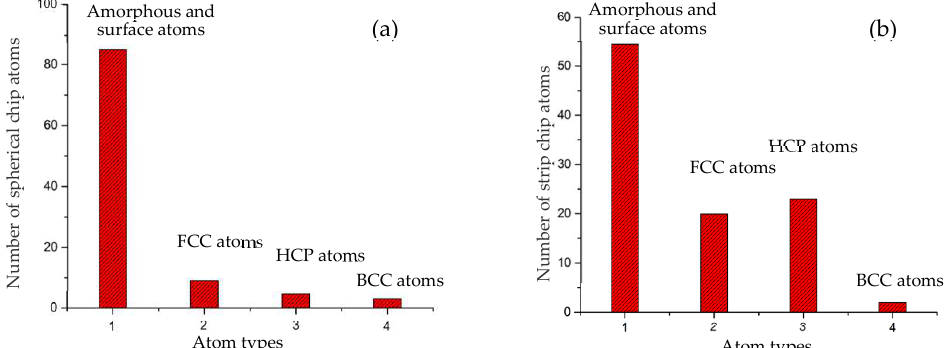
Figure 16. Atomic proportions of different chip forms. ( a ) Proportion of different atoms in the spherical chip; and ( b ) proportion of different atoms in strip chip.